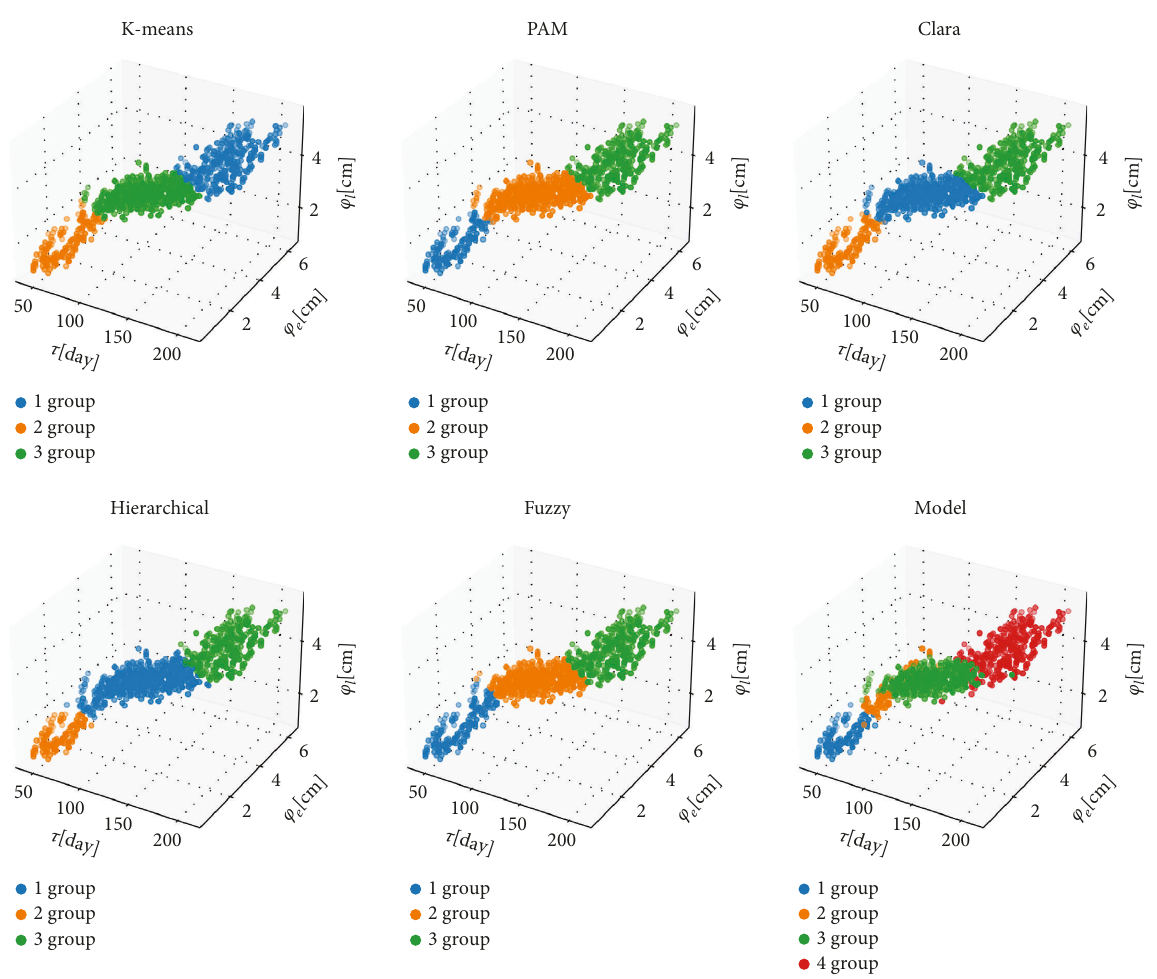
Figure 3: Selection of the linear section using six different agglomeration Table 2: Distribution of the number of members in the linear section of the sigmoidal model according to the grouping method and time interval truncated at 5%.